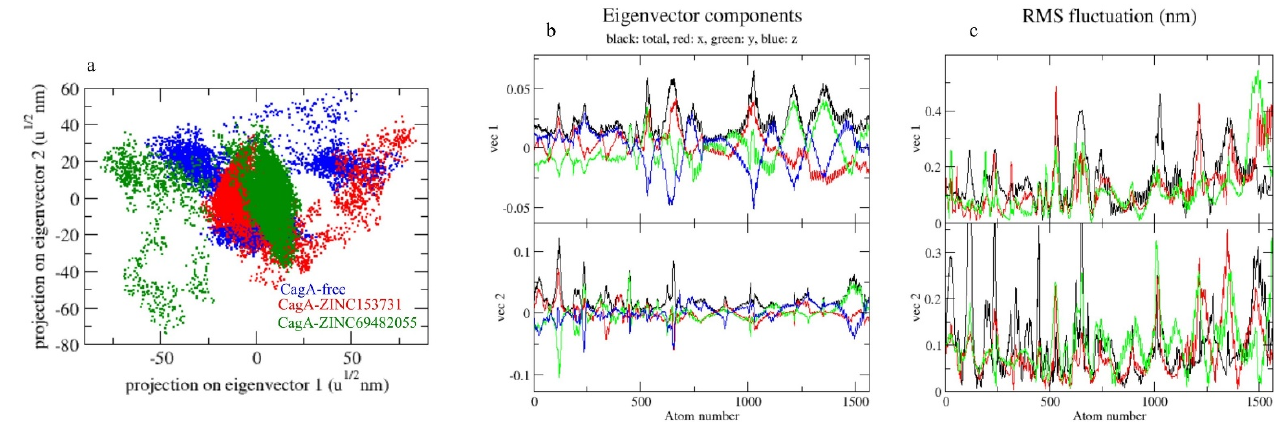
Figure 8. The 2D projection of complexes. ( a ) CagA-free, CagA-ZINC153731, and CagA-ZINC69482055, ( b ) Eigenvector components, ( c ) RMS fluctuation. Gibbs’ free energy (GFE) landscape was also computed with Gromacs analysis com- mands and projections of their respective first (PC1) and second (PC2) eigenvectors. The comparable GFE contour map showed darker blue shades representing less energy. The global minima of CagA fluctuated during the simulations due to the complexes binding to CagA. CagA-free and CagA-ZINC153731 showed similar projections and CagA- ZINC69482055 showed different global minima, indicating that the ZINC69482055 com- pound formed a more stable complex in protein proximity (Figure 9). Figure 9. GFE landscape of complexes. 4. Conclusions CagA inhibition is a novel approach for preventing the development of GC. For a long time, natural compounds have been the most important source of medicines for the treatment of many ailments. This study found that ZINC153731, ZINC69482055, and ZINC164387 efficiently bind to CagA protein and interact with the crucial CagA protein residue (Arg624). The study suggested that these compounds could be used as possible inhibitors of CagA protein in the fight against GC.